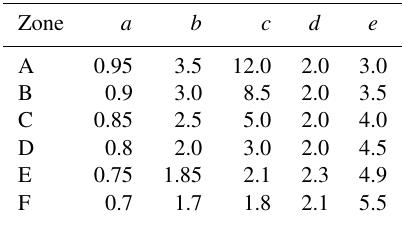
, corresponding to one representative station of each zone listed in Table 1, considering p Table 2. Numerical coefficients for SMF expression (Eq.